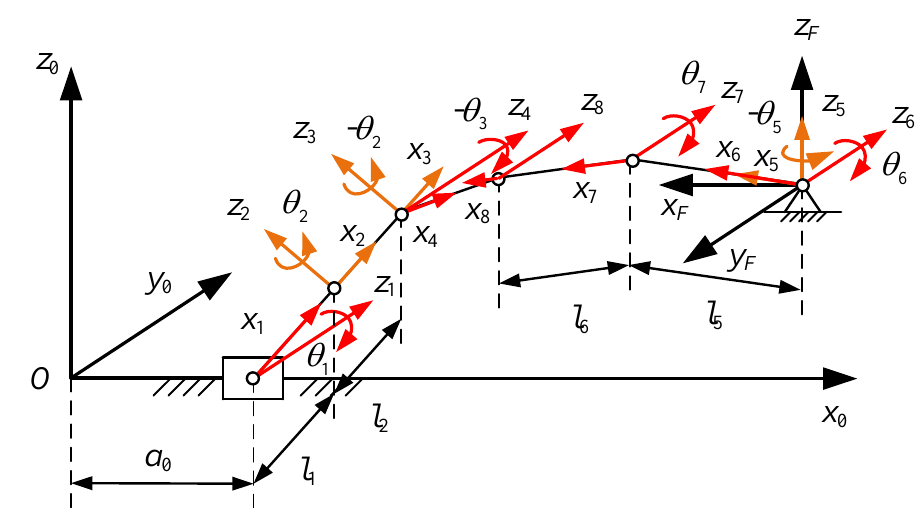
Figure 5. Human-robot hybrid linkage coordinate system. Table 2. Denavit-Hartenberg (D-H) parameters of the linkage